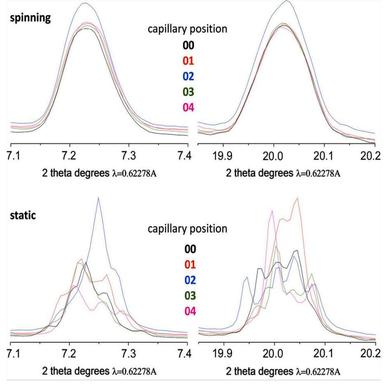
Comparison of the 1D synchrotron powder diffraction peaks at five capillary positions, after radial integration, for hydrating cement slurry at 14 h: (top) rotating and (bottom) static. Image reproduced from.